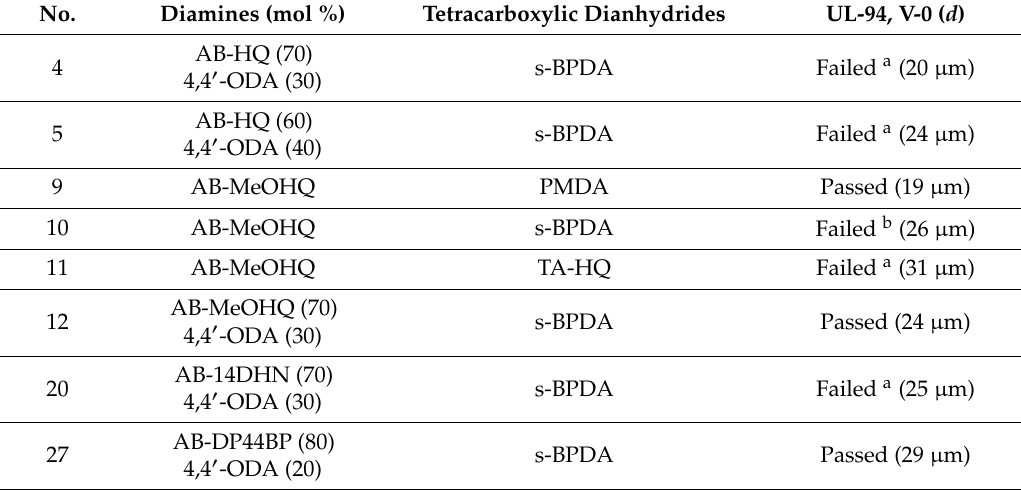
Table 8. Flame retardancy of the PEsIs derived from AB-Xs and rigid tetracarboxylic dianhydrides and related